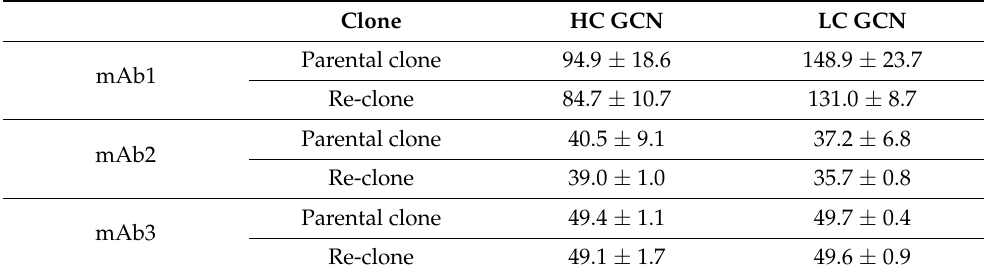
Figure 1. mAb1 genetic integration and structure analysis for the parental clone and re-clone. Southern blot analysis was used to determine the structural and integration profiles of the target HC and LC genes. Table 1. Target IgG heavy chain and light chain gene copy number comparison between the parental clone and re-clone for mAb1, mAb2, and mAb3. The values are reported as average ± standard deviation (n = 3).